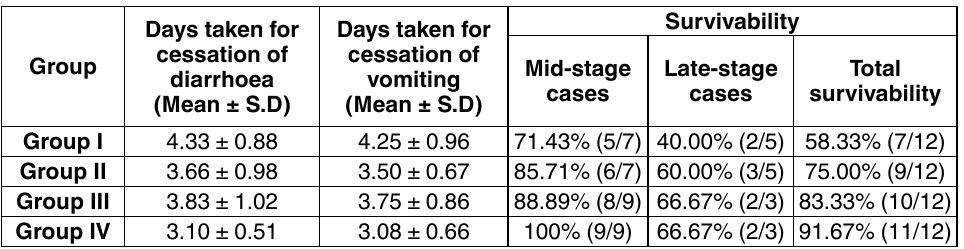
table 5. Comparative efficacy and survivability in various treatment protocols for CPV infectious dogs